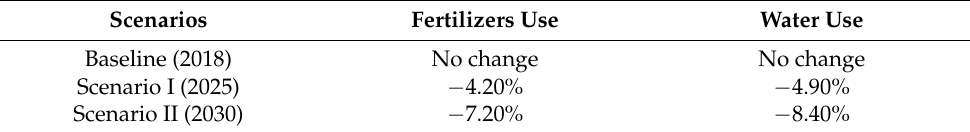
Table 1. Selected